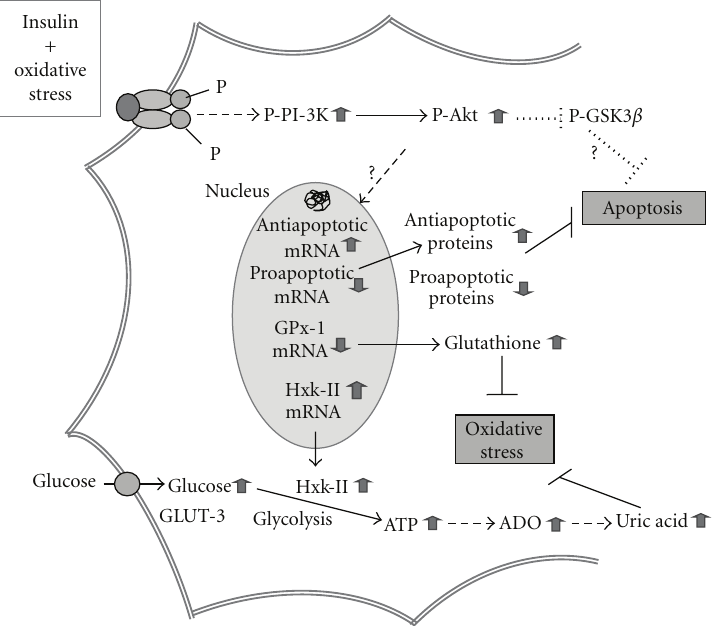
Figure 1: Stimulation of PI-3K/Akt signaling pathway after activation of IR/IGF-1R mediates insulin neuroprotection against damaging conditions. For example, insulin administration under oxidative stress phosphorylates IR and/or IGF-1R, which in turn activate the PI- 3K/Akt signaling pathway, regulating the expression of “candidate” proteins, namely, glutathione peroxidase-1 (GPx-1), hexokinase-II (Hxk- II), and also the antiapoptotic Bcl-2 and the proapoptotic caspase-3. Thus, oxidative stress, impaired glucose metabolism and, neuronal apoptosis are counterbalanced. Insulin also interferes with GSK-3 β signaling, decreasing its activated form and inhibiting apoptotic neuronal death under oxidized